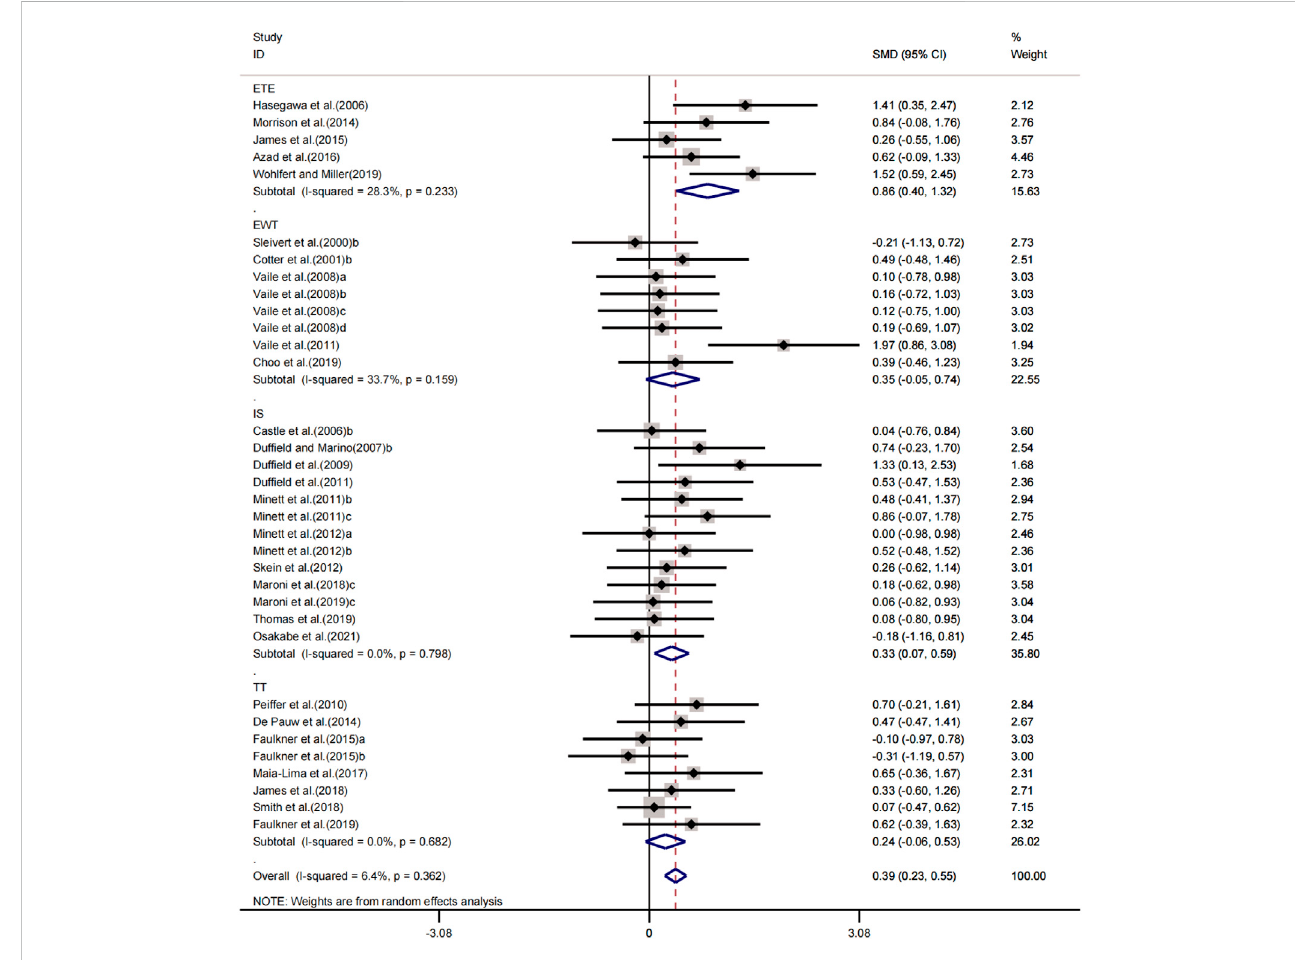
FIGURE 3 Funnel plots of publication bias for athletic